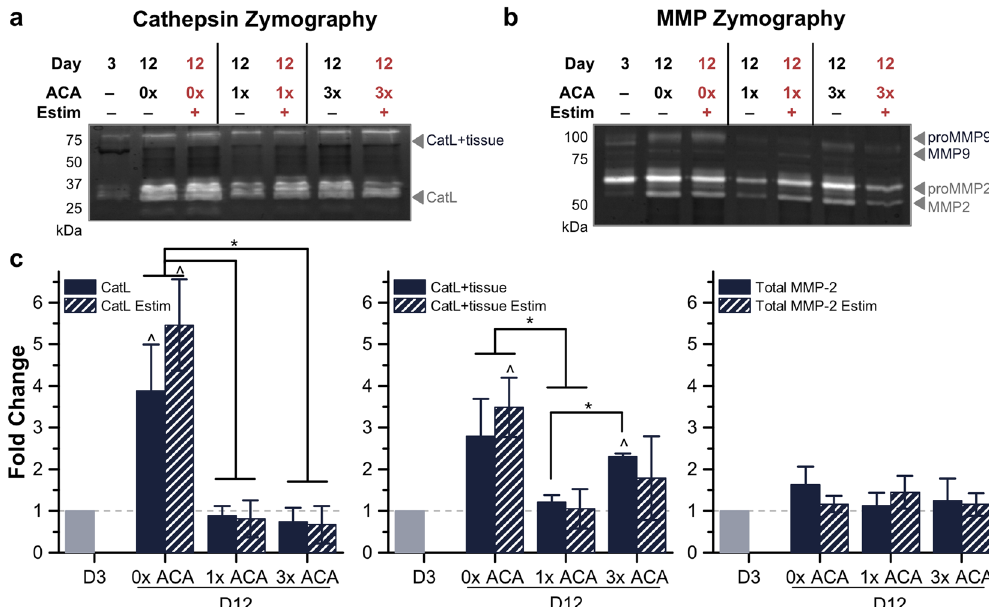
Figure 6. Comparison of Active Cathepsins and MMPs in 0x, 1x and 3x ACA Cultured Muscle Strips. ( a ) Cathepsin zymography identified the amount of active CatL and CatL + tissue and ( b ) MMP zymography identified the amount of active MMP-2 and MMP-9, with and without electrical stimulation, for day 12 conditions compared to the initial time point of day 3. ( c ) ACA prolonged the lifetime and reduced the amount of active CatL in locomoting biological machines. All plots represent mean ± SEM. * indicates significance ( p < 0.05) between conditions at the same time point; ^ indicates significance compared to initial time